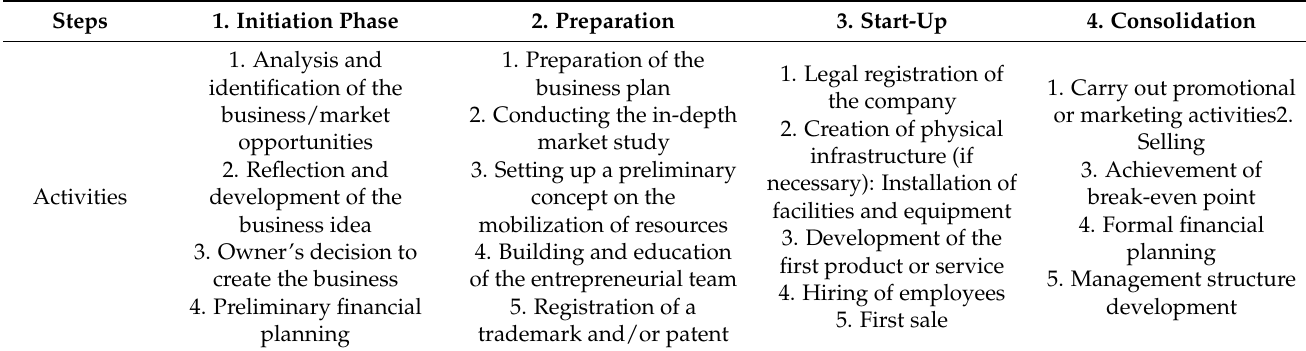
Table 1. Steps and activities in the process of starting a